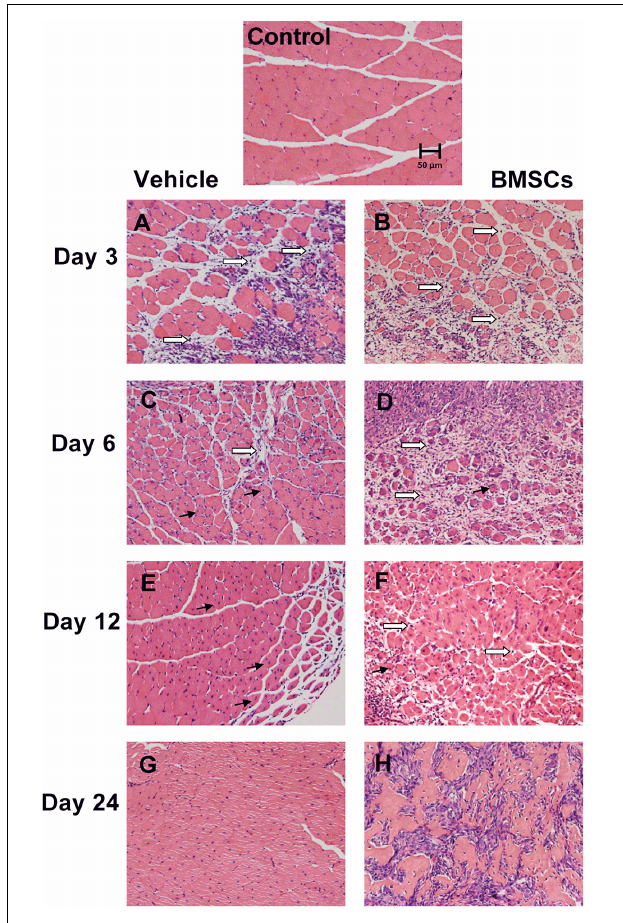
FIGURE 3 | Transplantation of BMSCs impaired skeletal muscle regeneration. Control, uninjured skeletal muscle; Vehicle, vehicle treated group after muscle contusion; BMSCs, BMSCs treated group after muscle contusion. Scale bars, 50 µ m; → centronucleated muscle fiber; ⇒ inflammatory cells. (A–H) Different time after skeletal muscle injury. There were more inflammatory cells, necrotic myofibers and less central-nucleated regenerated myofibers as compared with the vehicle treated mice, and BMSCs transplation impair muscle